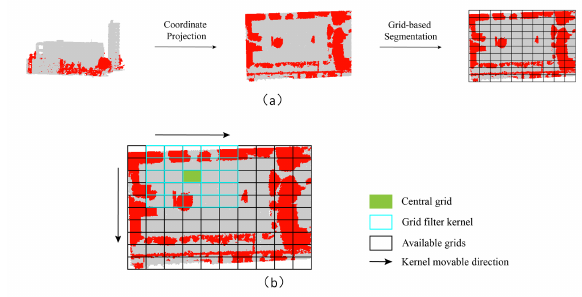
Figure 3. Grid-based elevation computation and filtering. (a) the illustrated point cloud data is on the left and the 2D-projected data with grid meshes is on the right. (b) grid filter examining anomaly of calculated elevation value in grids